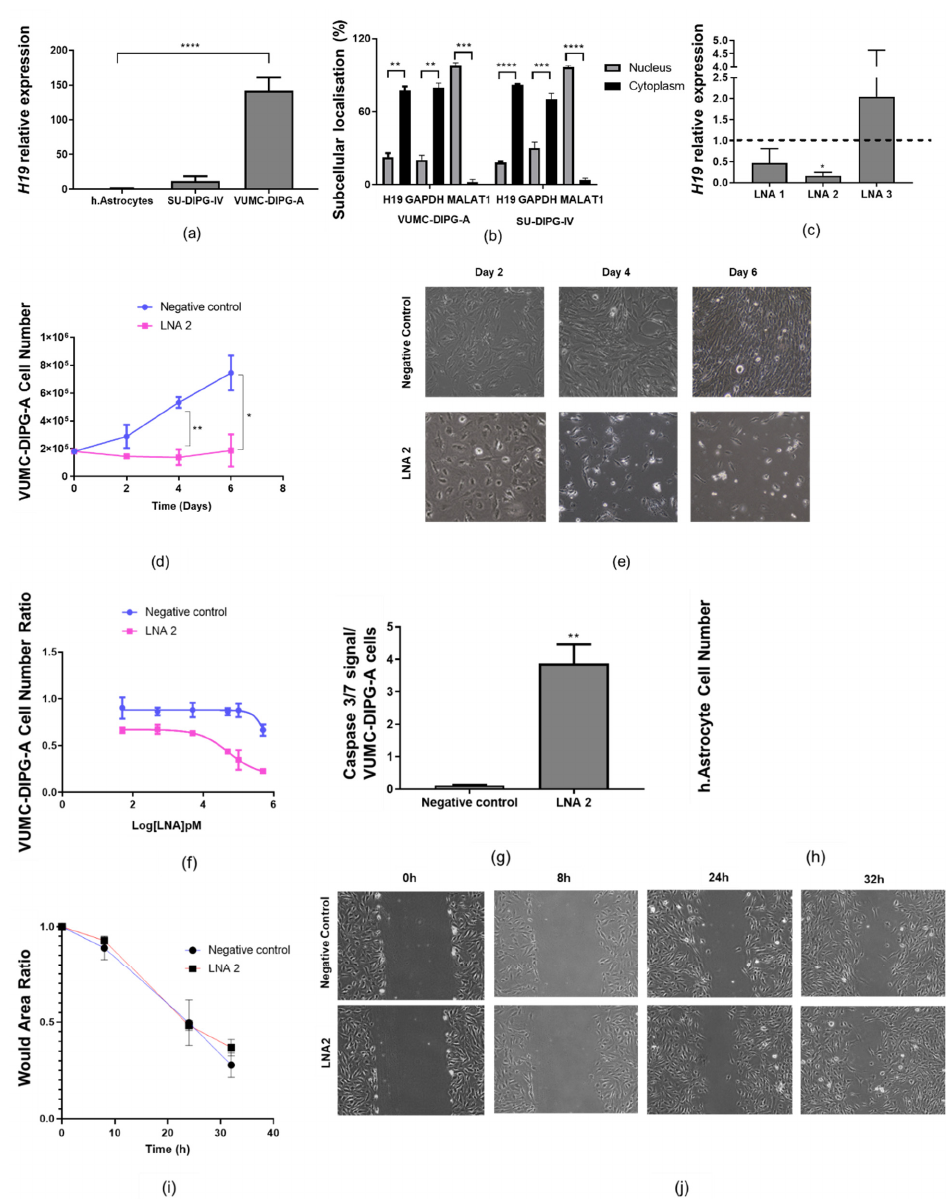
Figure 2. H19 is required for DIPG cell proliferation but not migration. ( a ) Expression (qPCR) of H19 lncRNA in a panel of DIPG cancer cells and a non-neoplastic human astrocyte cell line ( n = 3). ( b ) Subcellular localisation of H19 in VUMC-DIPG-A and SU-DIPG-A cells. Internal control included GAPDH (cytoplasm control) and MALAT1 (nuclear control) ( n = 2 and n = 3, respectively). ( c ) H19 RNA relative expression on LNA-silenced VUMC-DIPG-A cells (LNA1, LNA2, and LNA3) to negative control LNA-silenced VUMC-DIPG-A cells ( n = 3). ( d ) Trypan blue exclusion cell number of VUMC-DIPG-A after 2, 4, and 6 days post-transfection with LNA2 or negative control LNA ( n = 3). ( e ) Representative brightfield image of LNA2- or negative control LNA-transfected VUMC-DIPG-A cells after 2, 4, and 6 days. Magnification 10 × . ( f ) Dose response (0.05 to 500 nM) effect of LNA7 silencing on VUMC-DIPG-A cell number ( n = 2). ( g ) Cell viability-adjusted activity of caspase 3/7 after 4 days of LNA2-mediated H19 knockdown in VUMC-DIPG-A cells ( n = 3). ( h ) Cell number of normal human astrocytes after transfection with either LNA2 (50 nM) or negative control LNA on day 4 ( n = 3). ( i ) Wound healing assay showing wound area ratio closing at 8, 24, and 32 h post-scratch ( n = 3). ( j ) Brightfield representative images of wound healing assay. Magnification 10 × . Data on ( a ) was analysed with a one-way ANOVA followed by Dunnett’s multiple comparison test. Data on ( b – d ) were analysed with a two-way ANOVA with Sidak’s post-hoc test for multiple comparison. Data are shown as mean ± SD. Significant values were * p < 0.05, ** p < 0.01, *** p < 0.001, or **** p <